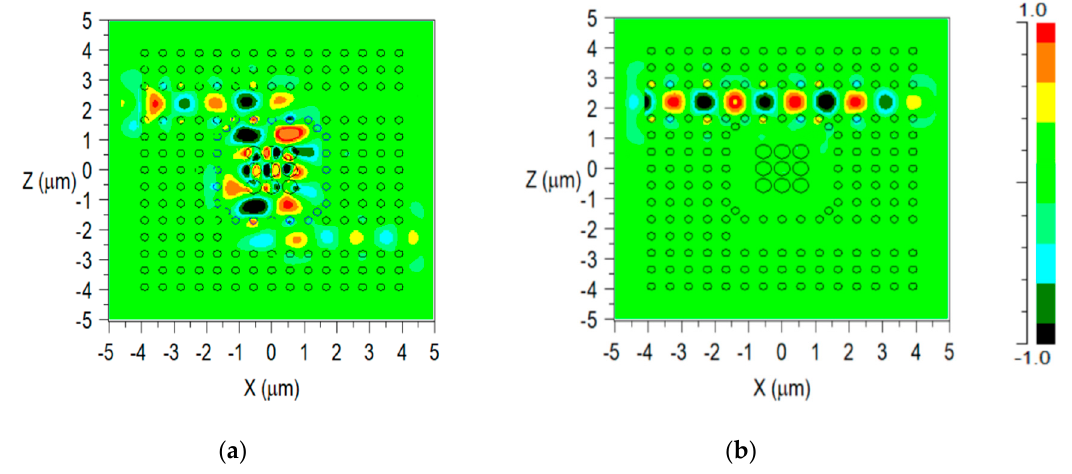
Figure 5. Electric field distribution into the structure for: ( a ) I = 0.45 W/µm 2 ; ( b ) I = 0.1 W/µm 2 .